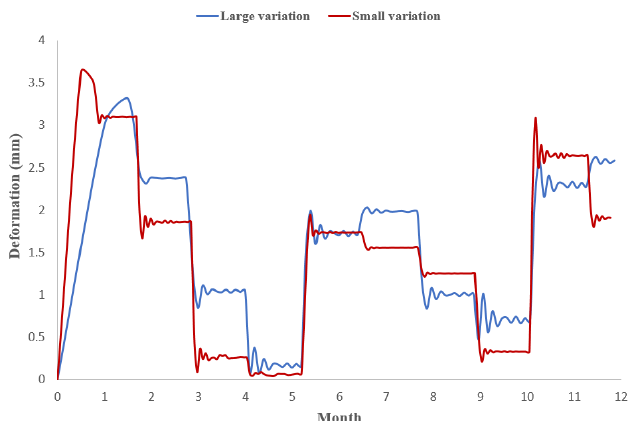
Figure 10. Comparison of the structure’s deformation due to two types of temperature loading, namely large and small variations.